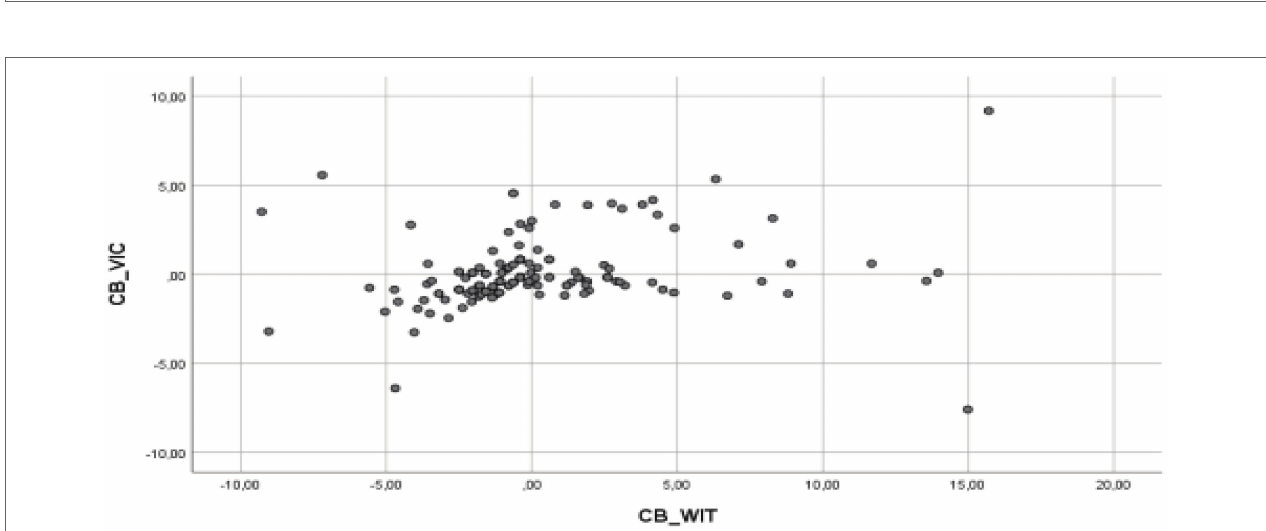
FIGURE 2 | Partial regression graphs of the cyberbullying role of victims criterion variable (CB_VIC), with the cyberbullying role of the bully predictive variable (CB_ HAR), included in the model.